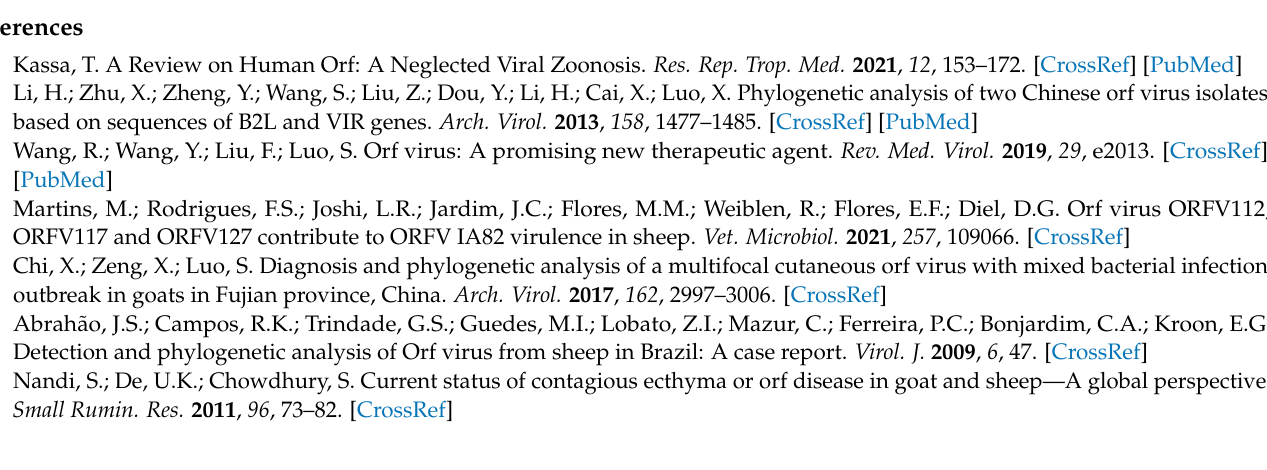
50 µ m. Figure S3: Uncropped Western blot. A and B: OFTu cells transfected with pcDNA3.1-HA- B2L -P2A-Flag- F1L plasmid were quantified and normalized to GAPDH. C: the purified recombinant B2L protein, the intden of 62 kDa band is about 122322. D: the purified recombinant c F1L protein, the intden of 37 kDa band is about 49511. Figure S4: Corresponding to Figure S1, uncropped Western blots are